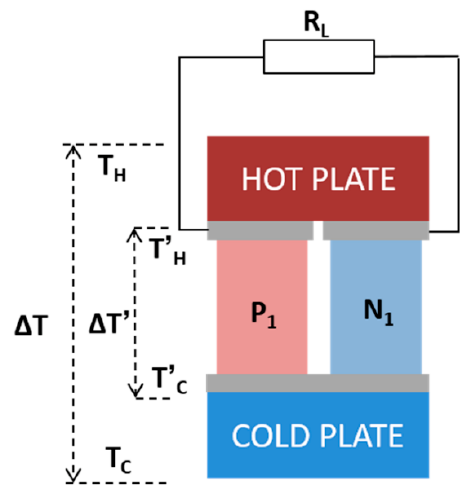
Figure 1. TEG internal components.